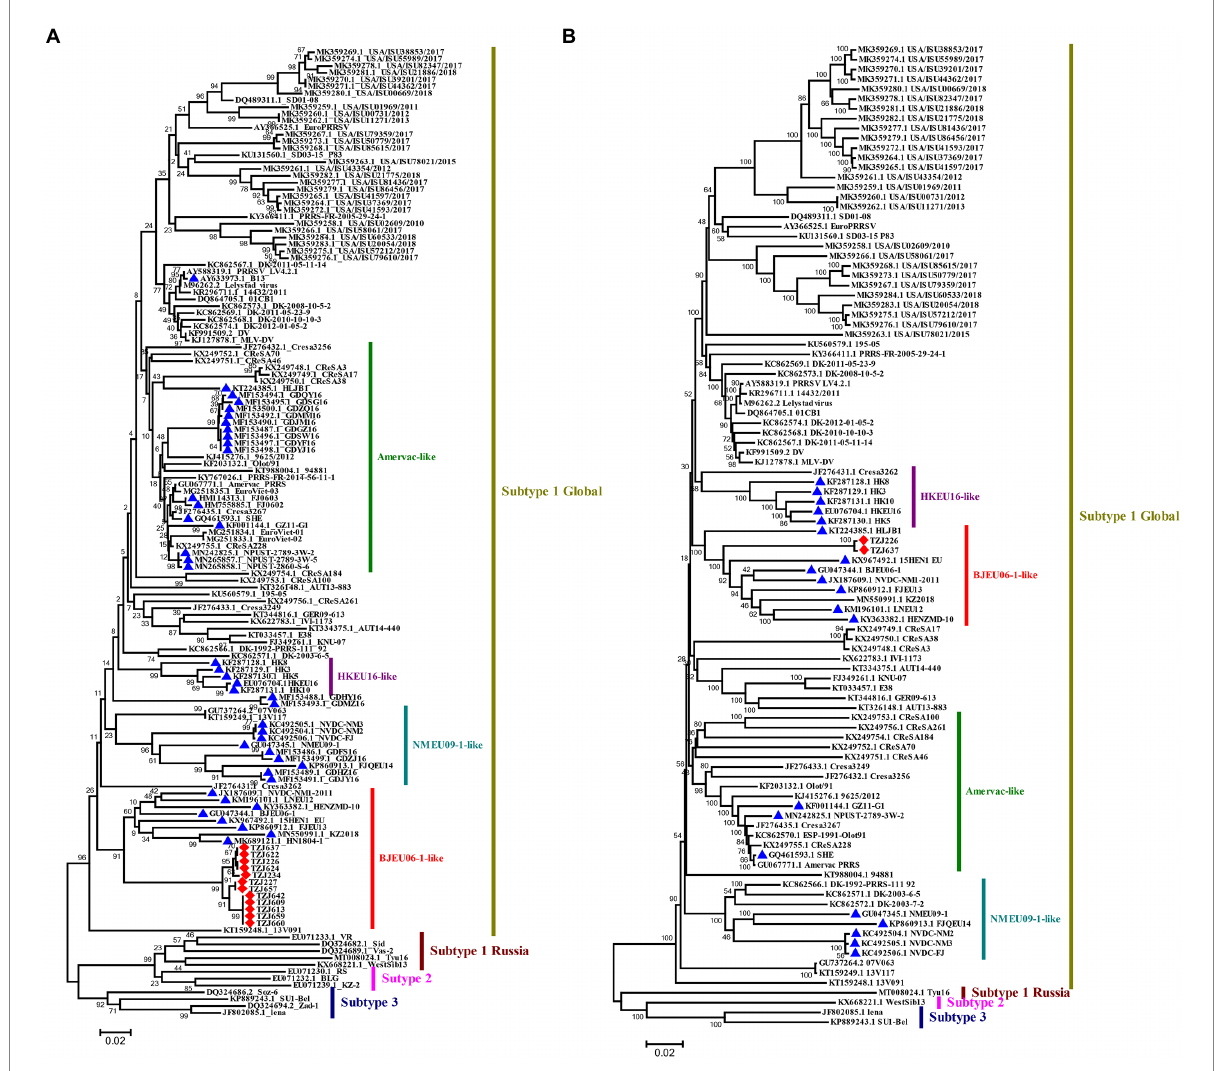
FIGURE 2 Phylogenetic analysis of PRRSV-1. (A) Phylogenetic tree constructed based on the ORF5 gene of PRRSV-1 isolates and reference PRRSV strains from each subtype. (B) Phylogenetic tree constructed based on full-length genomes of 2 PRRSV-1 isolates and reference PRRSV strains from each subtype. In the NCBI library, the PRRSV-1 strains from China and the PRRSV-1 strains from the pig farm are marked with ▲ and ◆ , respectively. Chinese PRRSV 1 isolates all belong to subtype 1 and can be divided into four subgroups (Amervac-like, BJEU06-1-like, HKEU16-like, and NMEU09-1-like isolates). The scale bars indicate the number of nucleotide substitutions per